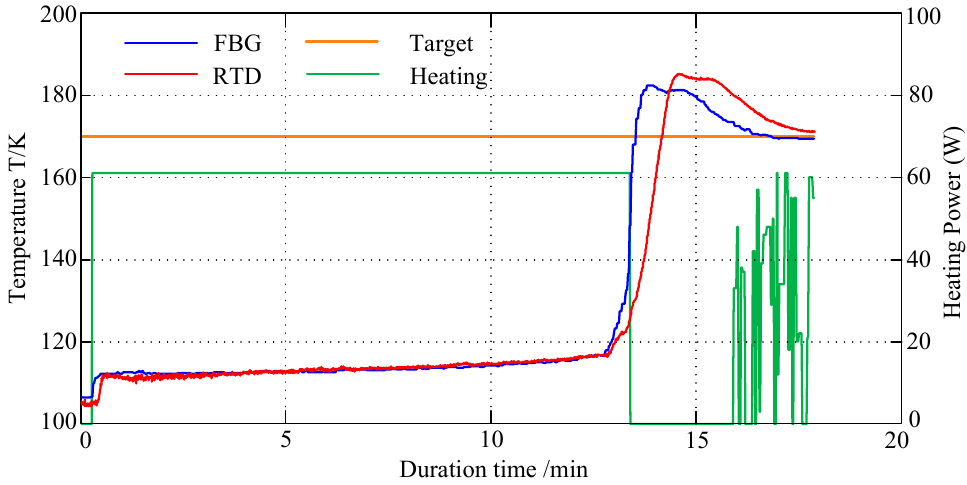
Figure 8. Temperature response time test of cryogenic tank: FBG vs. RTD.